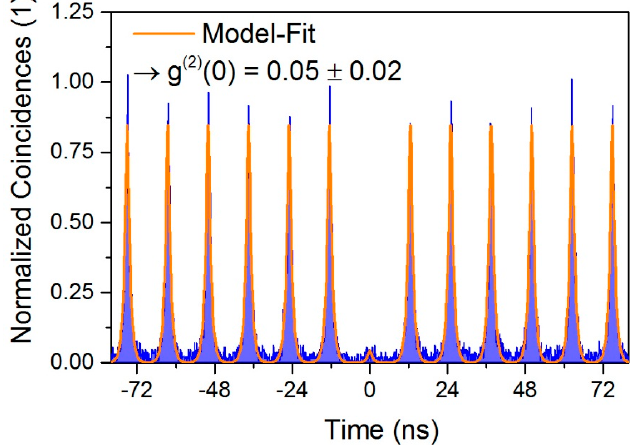
Figure 4. Photon-autocorrelation measurement of the X + emission-line under above-band pulsed excitation. Strong antibunching with g (2) (0) = 0.05 ± 0.02 is observed, clearly demonstrating triggered single-photon emission.